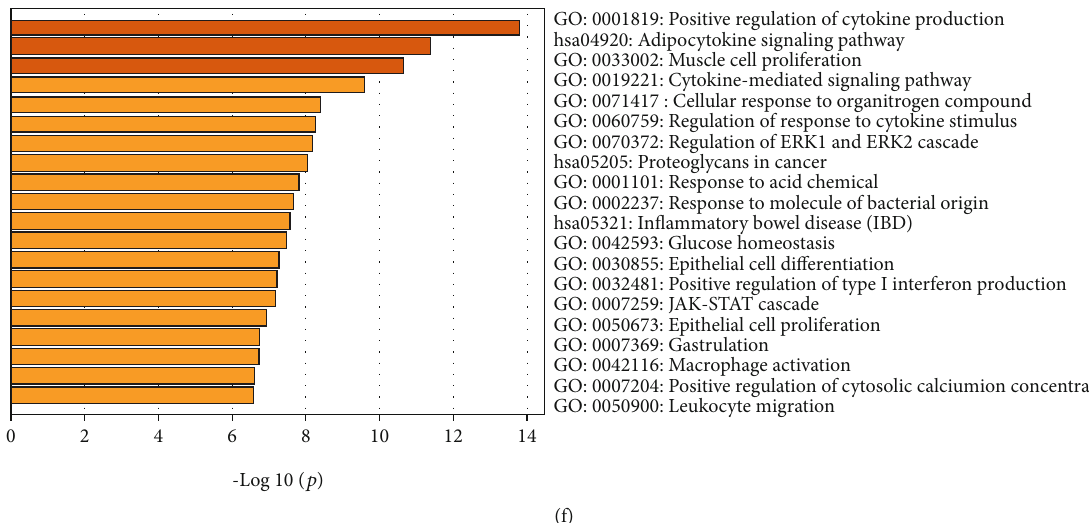
Figure 6: Two modules obtained from the downregulated PPI network and its functional enrichment analysis. (a) 266 downregulated in fl ammation-related DE mRNAs in COVID-19 were collected with Venn analysis. (b) PPI network of downregulated in fl ammation- related DE mRNAs. (c, d) Signi fi cant clustered modules from the PPI network. Green rectangles represent downregulated genes. The GO- BP terms and KEGG pathways enrichment analysis for module 1 ′ (e) and module 2 ′ (f), respectively, using the Metascape